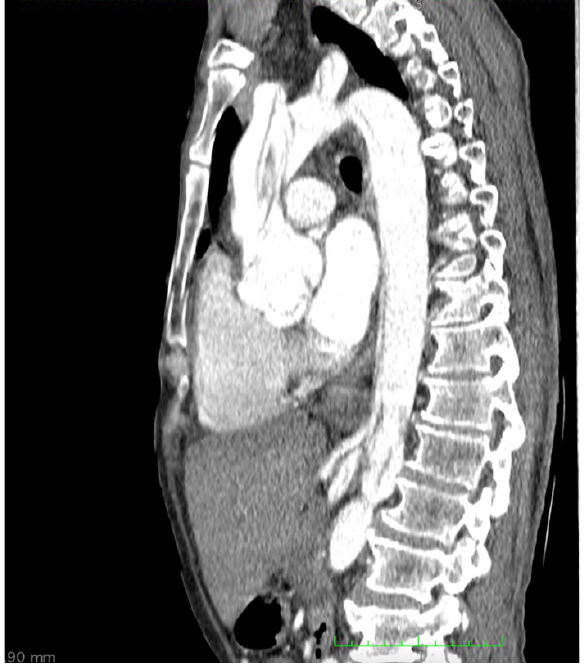
Figure 2. CT showing intimal flap at the level of the ascending aorta, aortic arch, thoracic and abdominal aortas and superior mesenteric artery. Celiac trunk with origin in a small true aortic lumen.